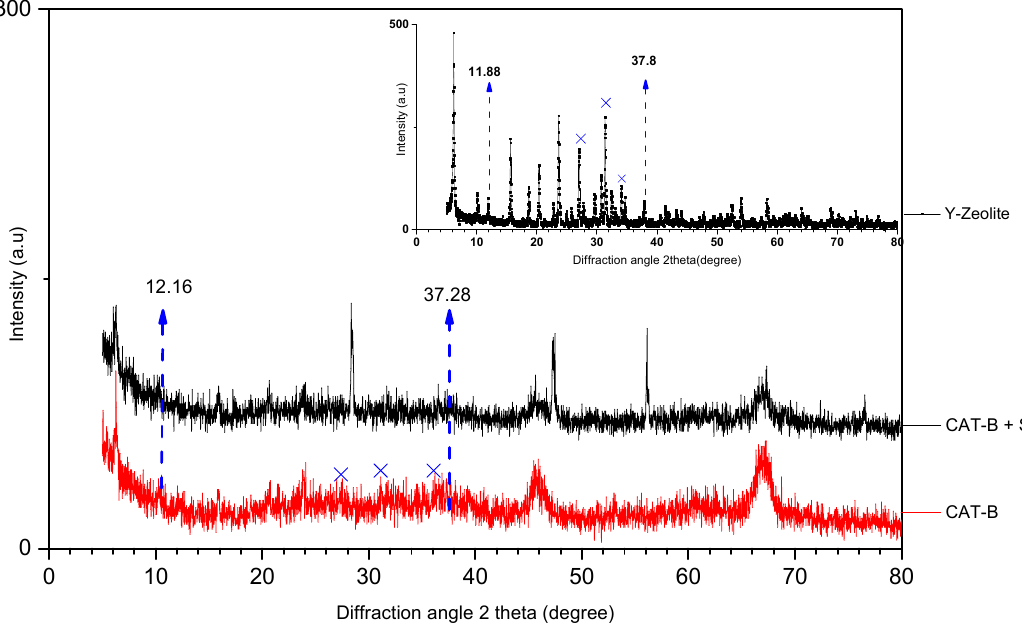
Figure 1. XRD diffractograms for a CAT-B sample of the present study mixed with pure silicon. Characteristic peaks for silicon are shown at 28.47, 47.47, and 56.12 degrees in the 2 θ scale and identified with the symbol x.